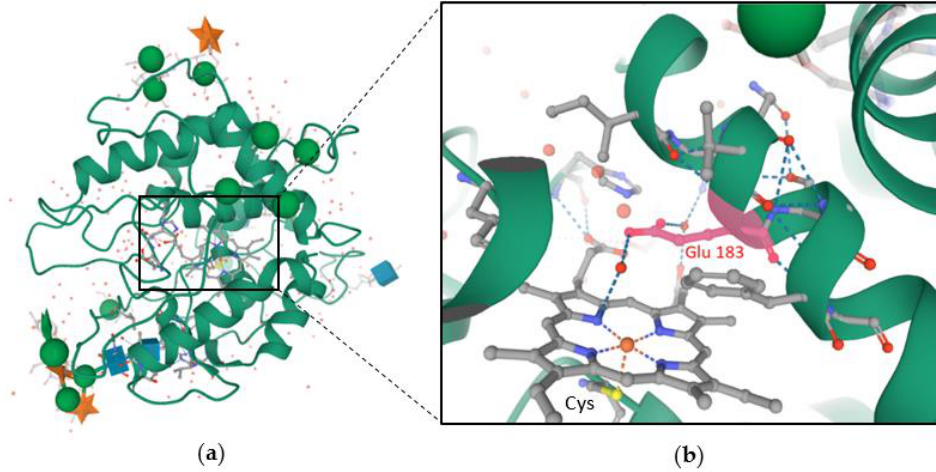
Figure 4. ( a ) Crystal structure of heme-chloroperoxidase from Leptoxyphium fumago (PDB ID: 1CPO). ( b ) Active site with glutamic acid 183 colored in pink.